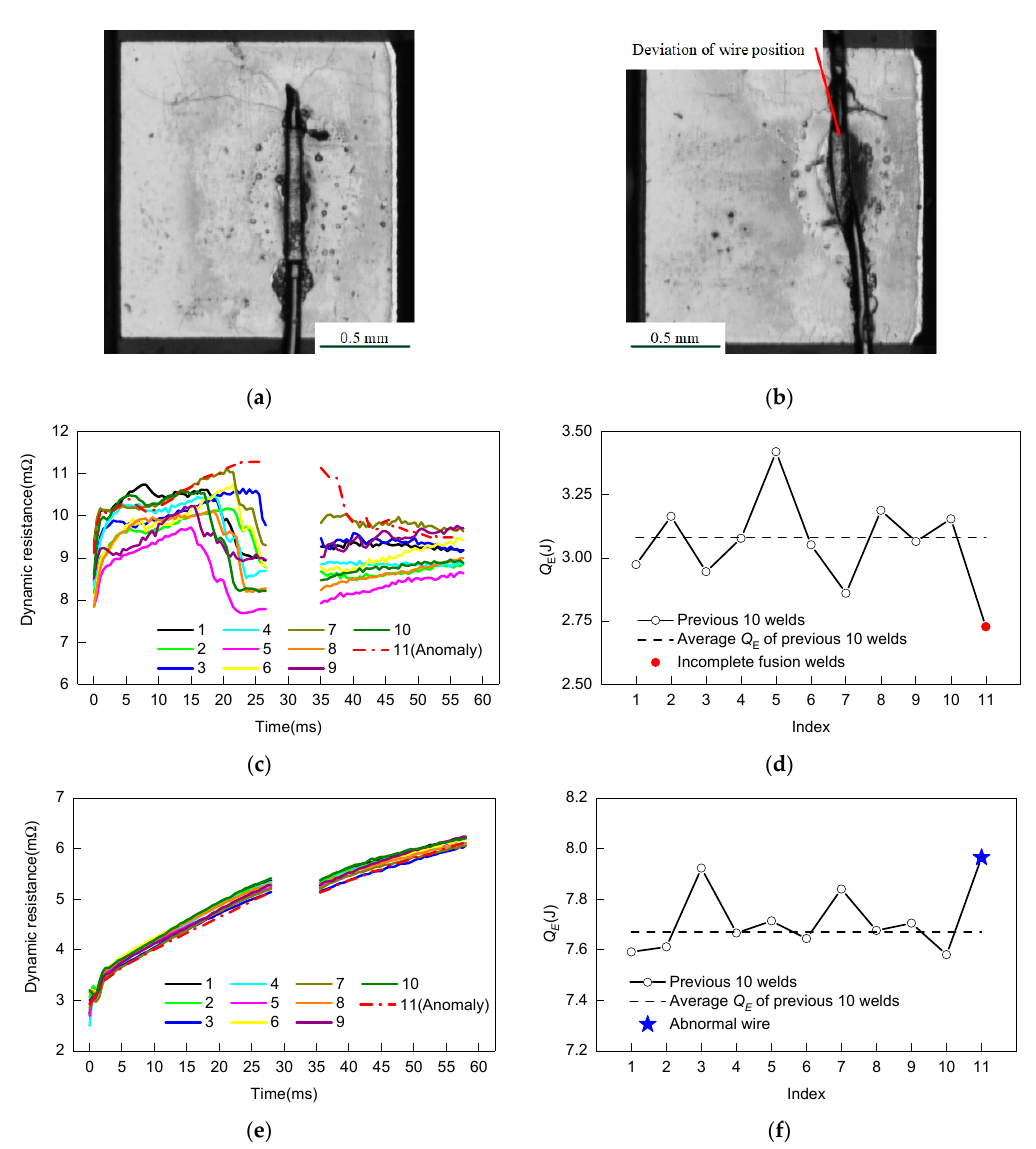
Figure 10. Abnormal welds and the previous 10 welds: ( a ) incomplete fusion weld; ( b ) abnormal wire weld; for incomplete fusion weld: ( c ) R t profile; ( d ) Q E ; for abnormal wire weld: ( e ) R t profile; ( f ) Q E .